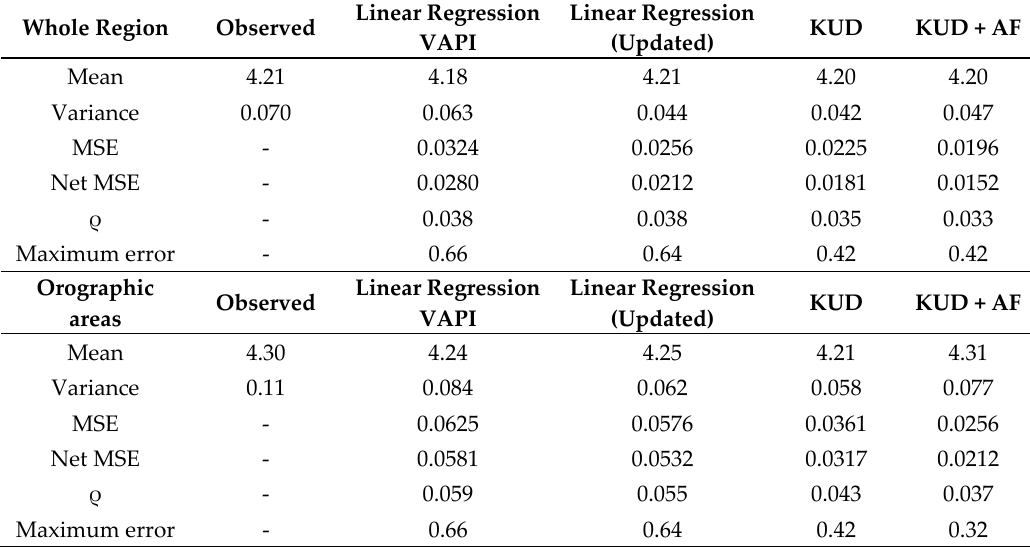
Table 7. Comparison with the main statistics related to different methods of spatial estimation. The proposed model is in the last column, indicated as